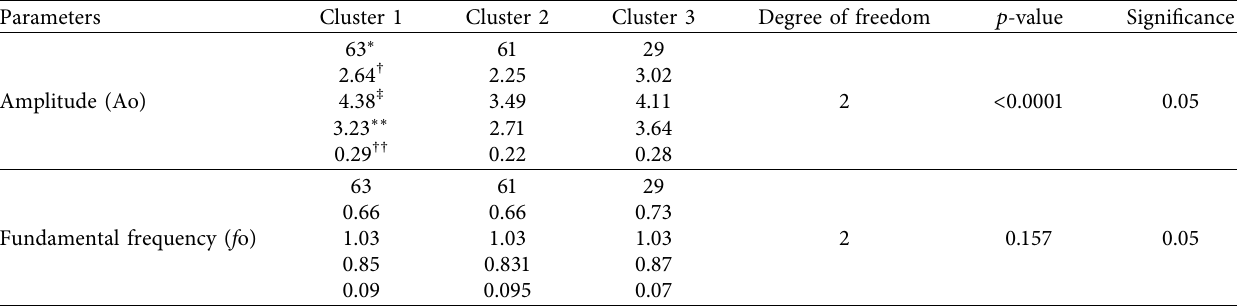
Table 4: Kruskal-Wallis test for fuzzy C-mean